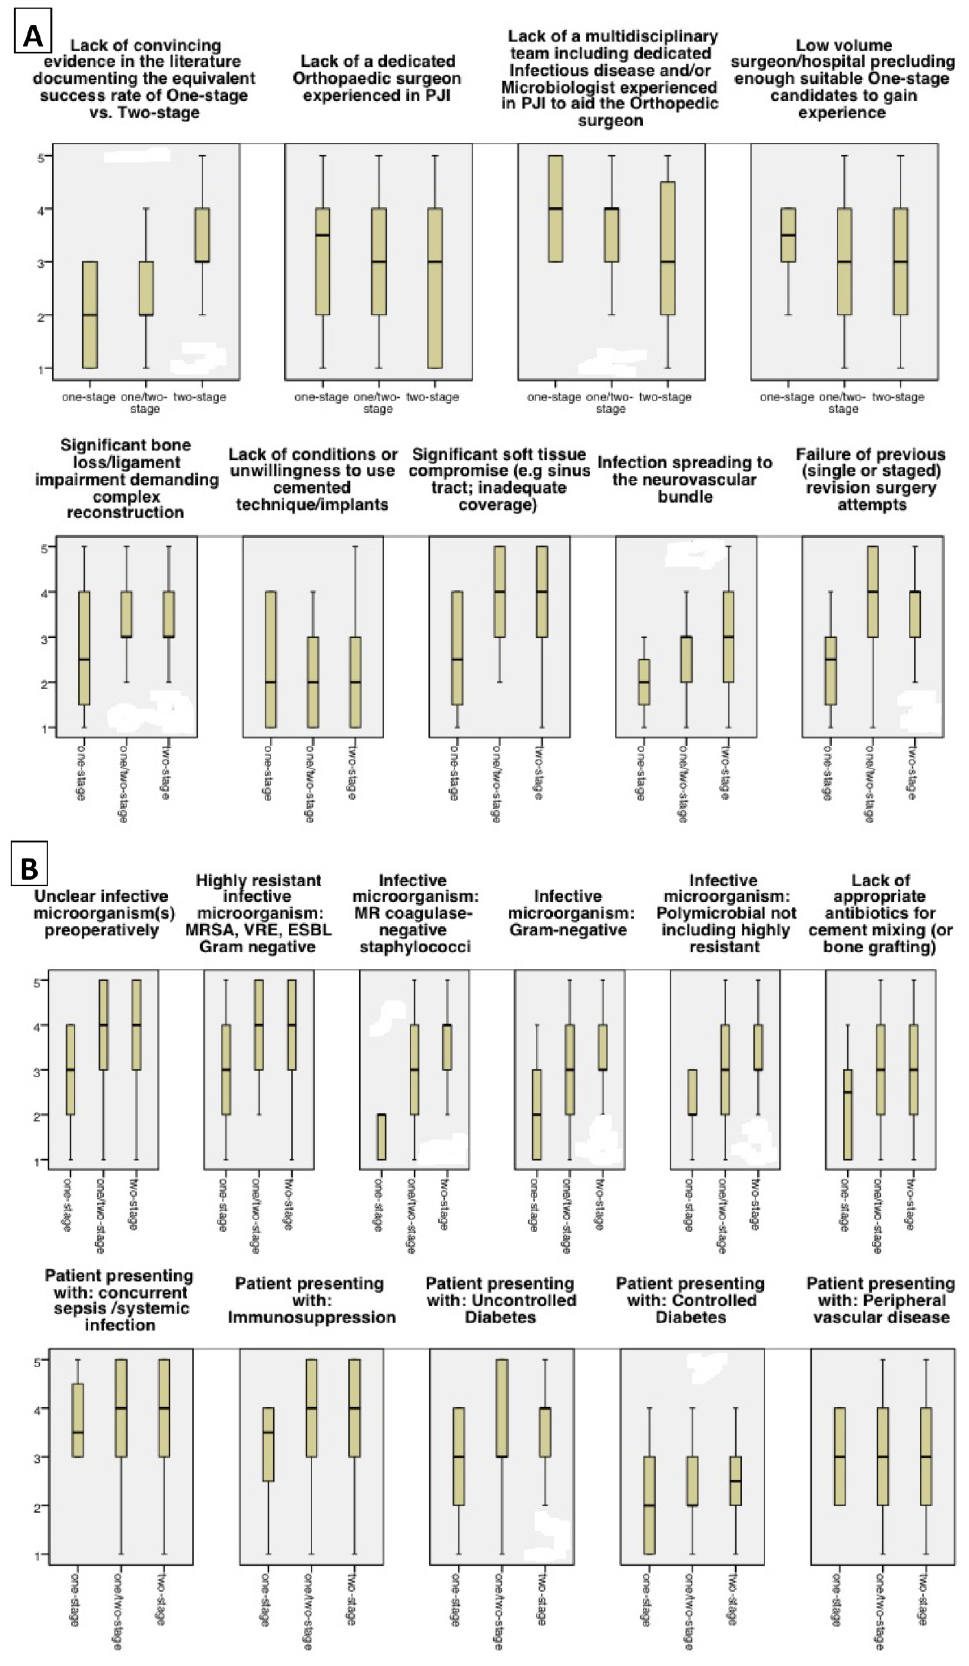
Figure 2. A. Importance of different factors according to the philosophy of revision. B. Importance of different factors according to the philosophy of